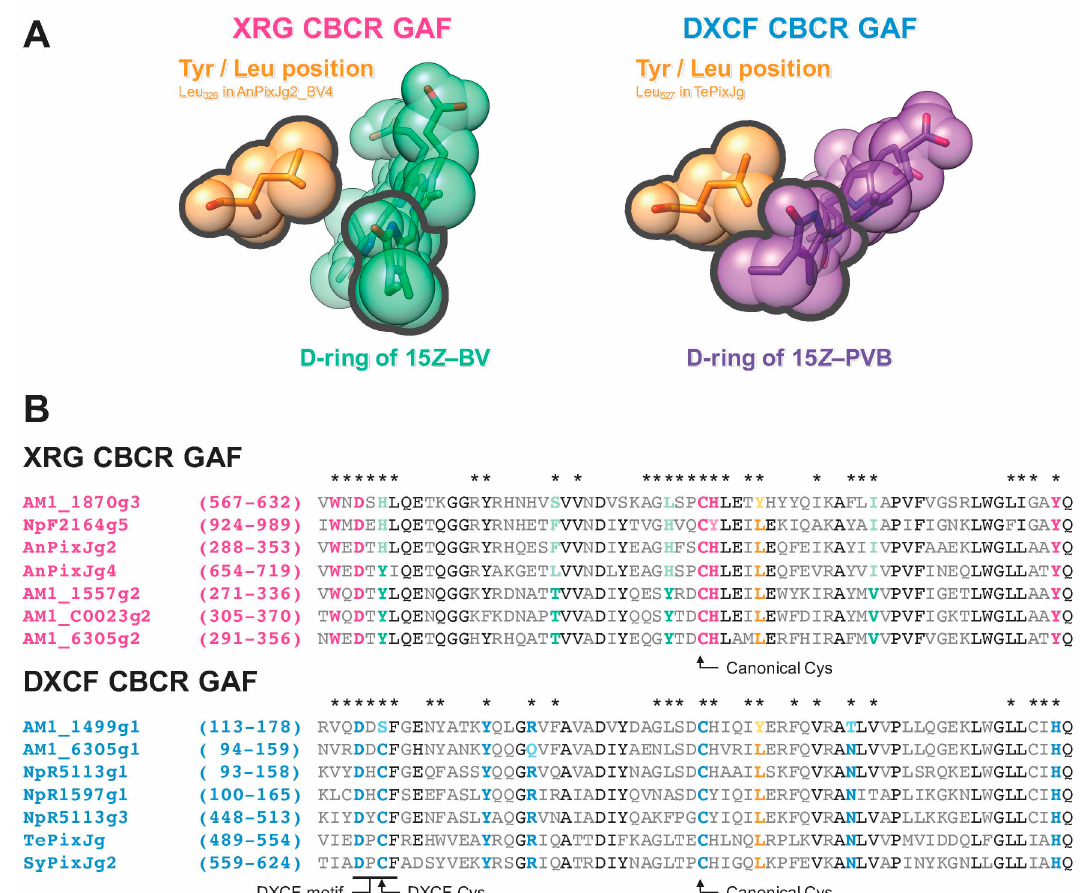
Figure 6. Tyr / Leu position is conserved in various CBCR GAF domains. ( A ) Leu residues (orange) on the Tyr / Leu position of XRG CBCR GAF domain (Leu 326 in AnPixJg2_BV4 of the Pfr form with 15 Z –BV (light green), PDB ID: 5ZOH [25]) and of the DXCF CBCR GAF domain (Leu 527 in TePixJg in the Pb form with 15Z–PVB (phycoviolobilin, red purple), PDB ID: 4GLQ [34]). These structures are shown by the stick and sphere models. ( B ) Sequence alignments of the XRG CBCR GAF (magenta) and DXCF CBCR GAF (cyan) domains. The Tyr / Leu position, orange; key residues for photosensory roles in the XRG (magenta), and the DXCF (cyan) groups; BV4 residues, light green; highly conserved residues, black. Asterisks are shown as amino acid residues within 6 Å of each chromophore.